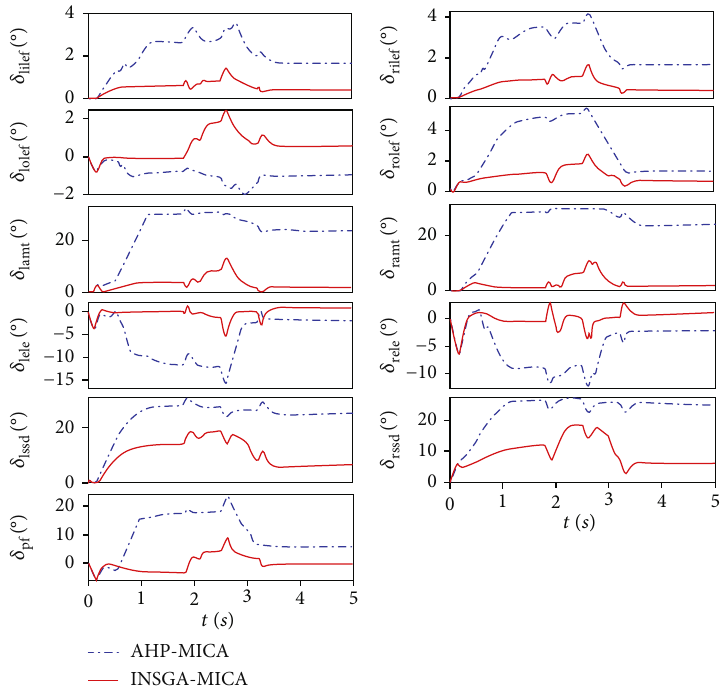
Figure 14: Control surface de fl ection